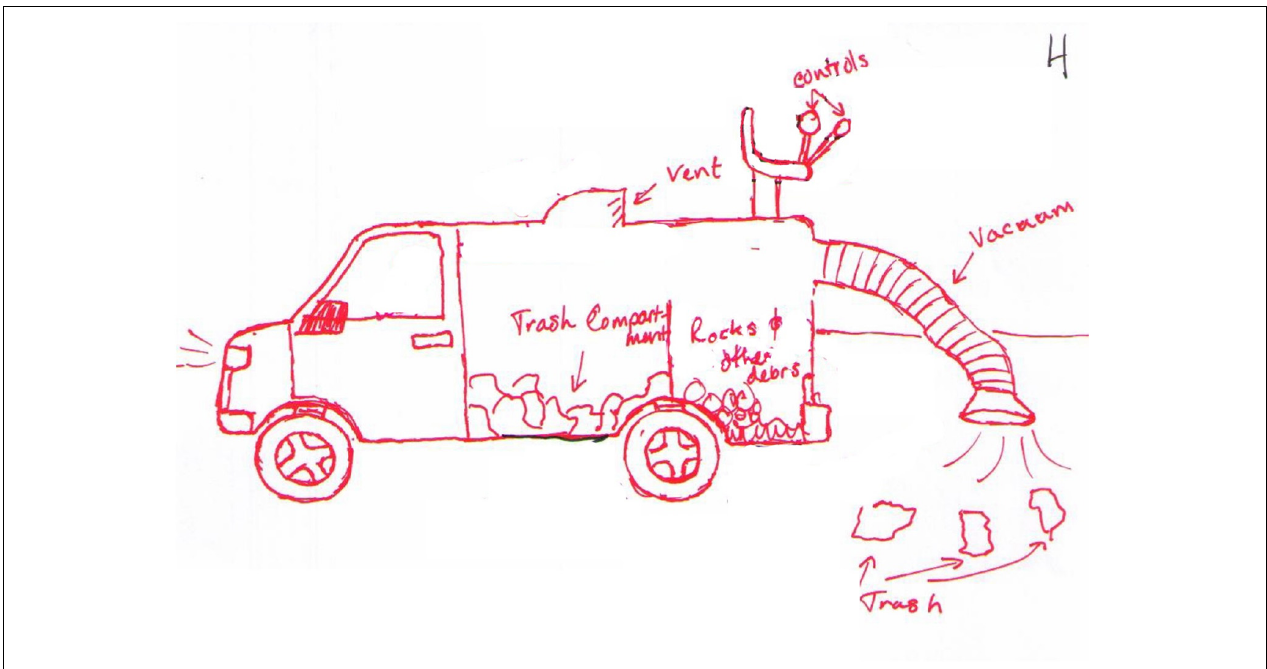
FIGURE 4 | A modified trash truck that received an originality score of